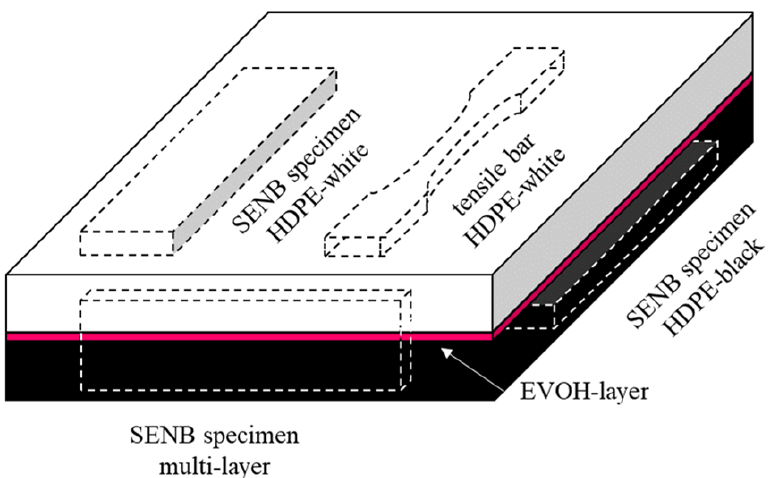
Figure 1. Schematic drawing of the used multi-layer plates and corresponding machined testing specimens. The plate consists of a black HDPE layer, an EVOH layer, and a white HPDE layer at the bottom, the middle, and the top, respectively.